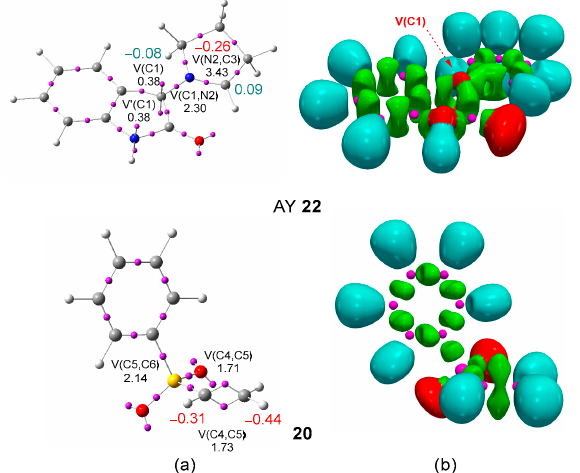
Figure 1. ω B97X-D/6-311G(d,p) ( a ) ELF basin attractor positions together with the most relevant valence basin populations, and ( b ) ELF localization domains represented at an isosurface value of ELF = 0.70, of AY 22 and phenyl vinyl sulphone 20 . Valence basin populations and natural atomic charges are given in average number of electrons, e. Negative charges are colored in red and negligible charges in green.